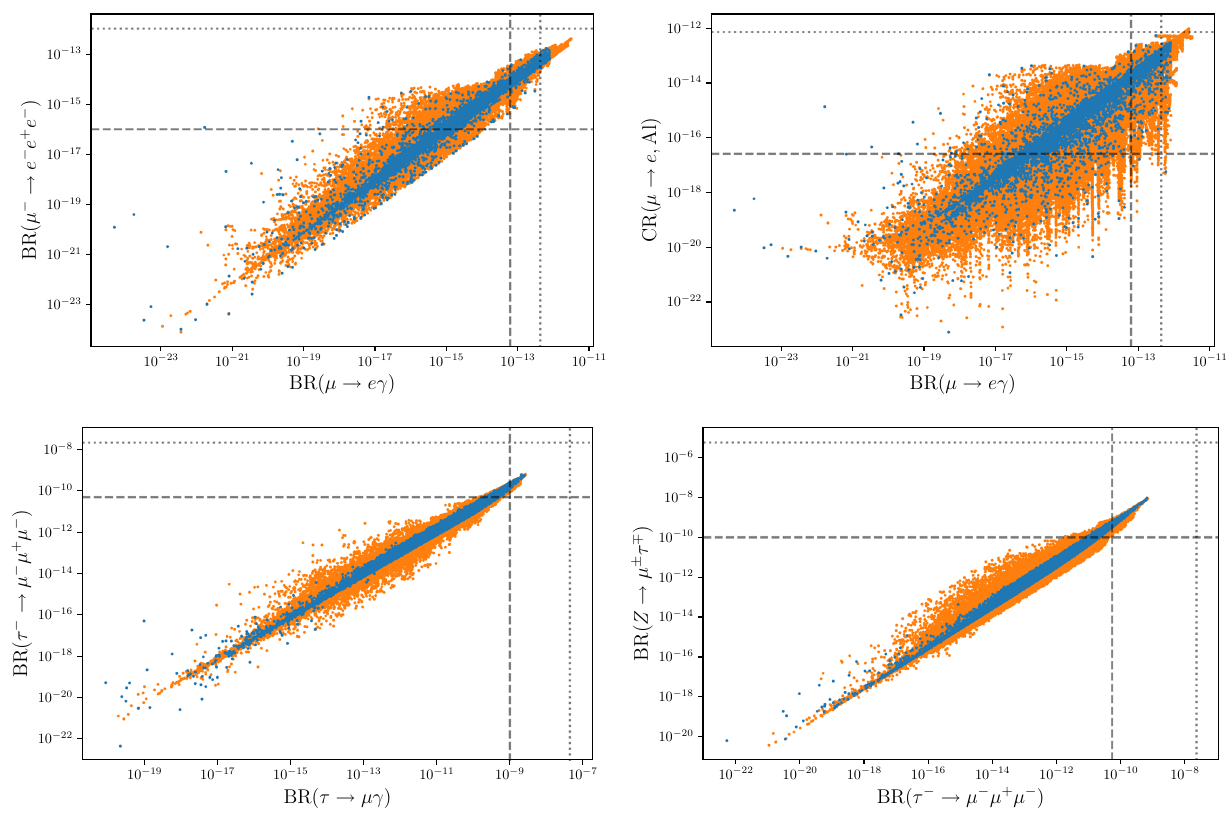
ϕ α = e ,μ,τ i and i , with